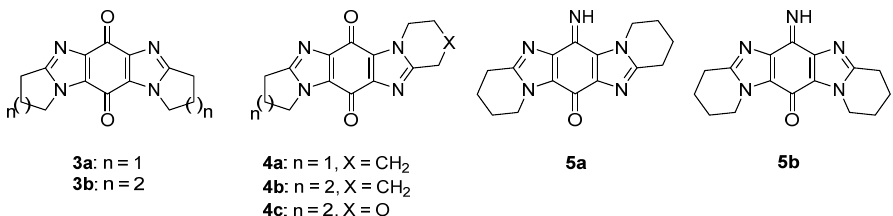
Figure 5. Imidazobenzimidazolequinones and iminoquinones [24–29].